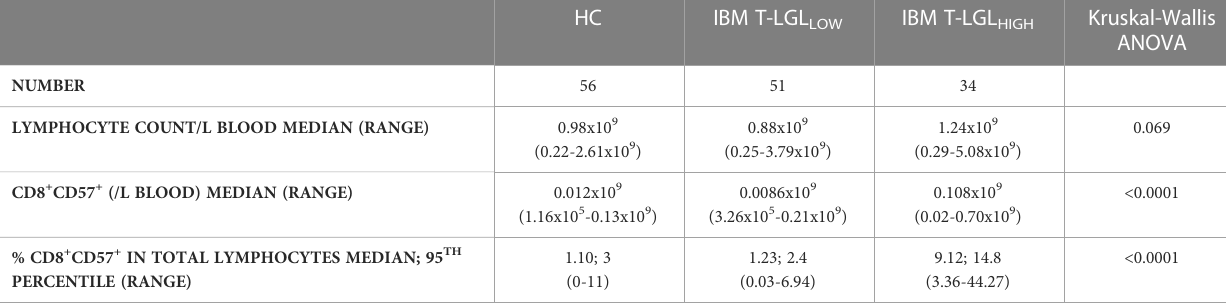
TABLE 2 Number of peripheral blood lymphocytes in HC and IBM T-LGL LOW and T-LGL HIGH donor groups.